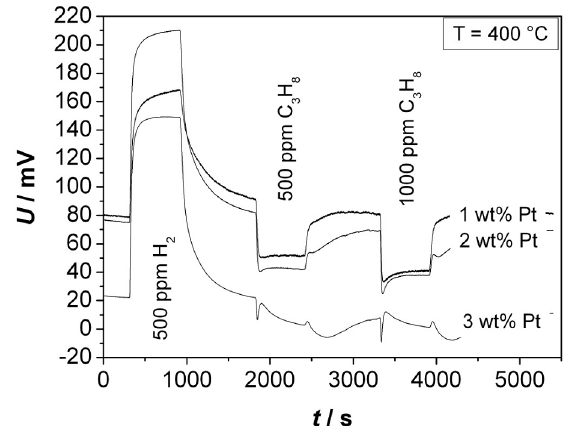
Figure 5. Potential difference U of sensors to H zeolites at 400 °C.